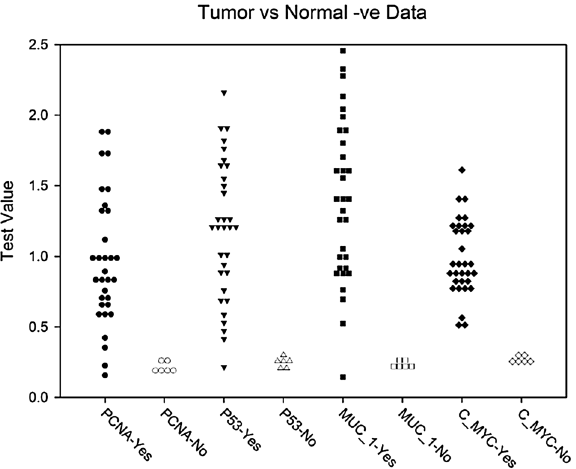
Figure 2. Measured values of four studied AAbs for six normal cats (No; white-filled symbols) and 32 cats diagnosed with mammary tumor (Yes; black-filled symbols) before application of any treatment. Figure was